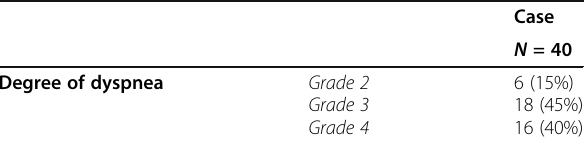
Table 4 Degree of dyspnea in the cases